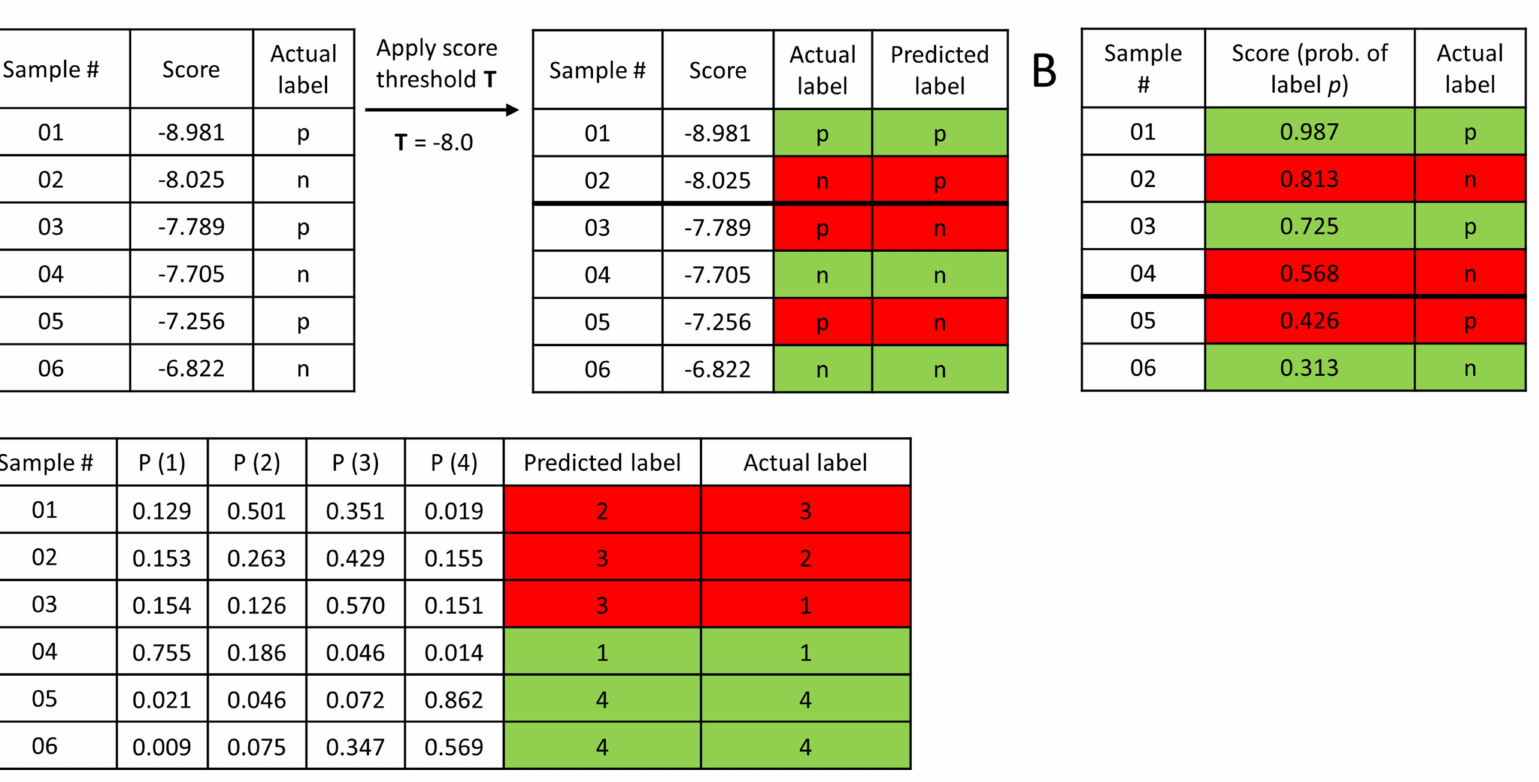
Figure 9. Mock datasets to showcase common classification scenarios. ( A ) In structure-based virtual screening, a docking score is commonly used as a rough estimator of the free energy of binding between ligand and protein (the smaller the better). Predicting a ligand to be active / positive requires setting a threshold value of the docking score ( T ): each ligand with a better score will be considered a predicted active / positive. ( B ) In 2-class classification, machine learning methods typically output probability values for each sample, for belonging to the positive class. A probability value of 0.5 or higher is a natural choice to assign the samples into the positive class. Naturally, other choices can be applied as well: in the above example, setting the threshold value to either 0.6 or 0.4 would reduce the number of misclassified samples by one. ( C ) In multiclass classification, the most straightforward option is to assign each sample to the class with the highest predicted probability. (Green: correct, red: incorrect